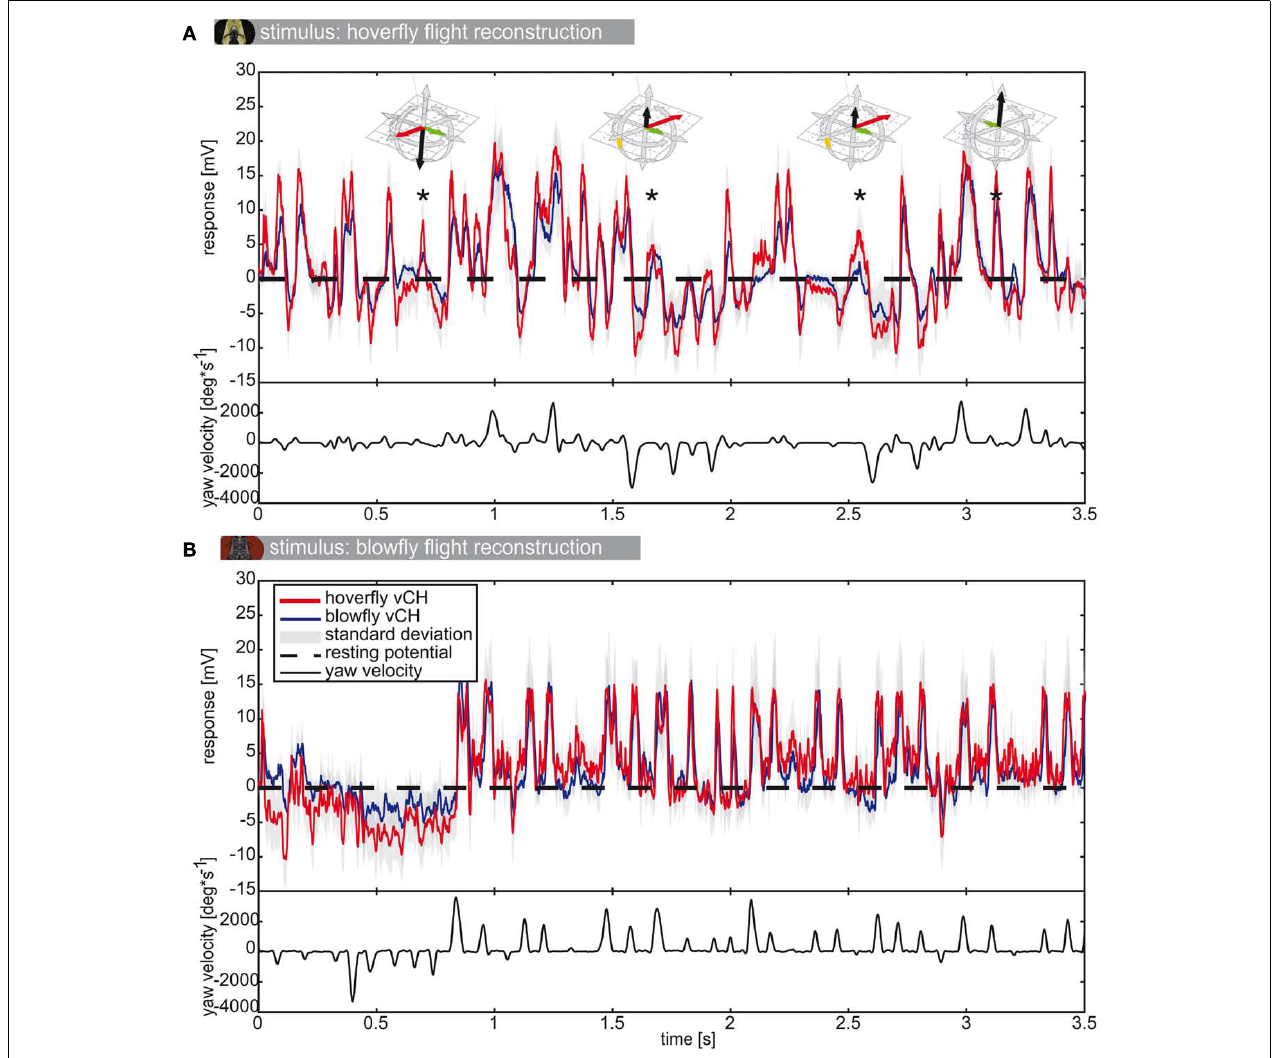
responses in black. In A strong depolarizations not accompanying fast yaw velocities were marked with an asterisk.The prototype assigned to the trajectory at each such instance is plotted above. (B) The responses of the same neurons to a Calliphora flight. Eristalis vCH N = 8, n = 3–11 | Calliphora vCH N = 5, n =